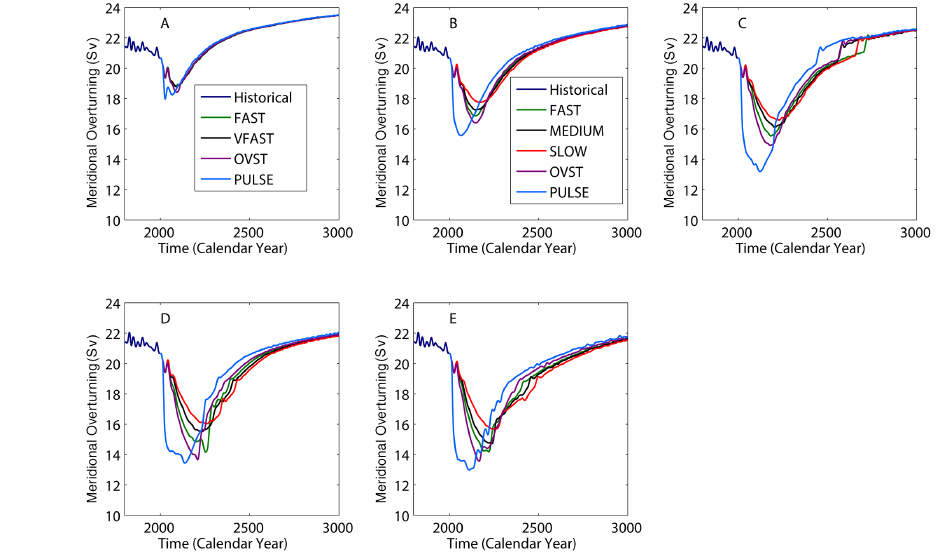
Figure 7. Atlantic Meridional Overturning Circulation (AMOC) index (defined as the meridional overturning streamfunction) for the 1275–5275GtC scenarios. (a) 1275GtC scenarios, (b) 2275GtC scenarios, (c) 3275GtC scenarios, (d) 4275GtC scenarios, and (e) 5275GtC scenarios. Note: legend for (b) also applies to (c–e) .